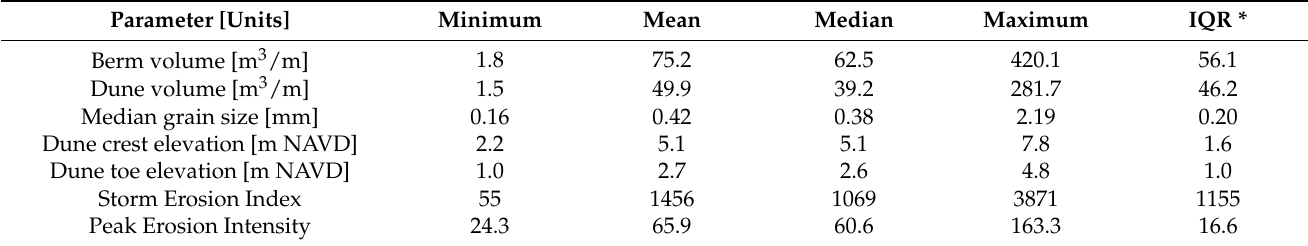
Table 5. Characteristics of compiled morphological and storm parameters in combined (training and testing) data sets. Parameter